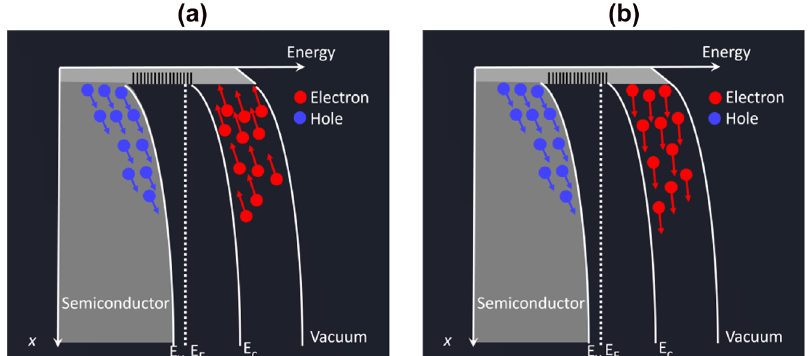
Figure 10: The band structure of a p-type semiconductor surface emitter utilizing (a) the built-in electric fi eld induced near the semiconductor surface and (b) photo- Dember